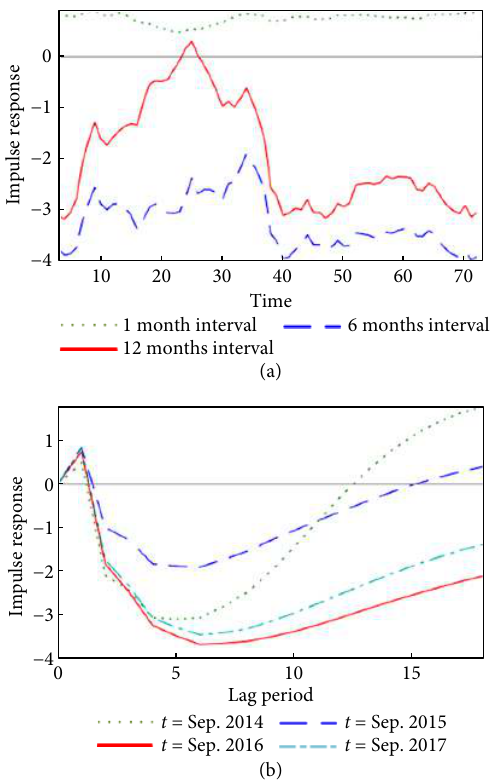
Fig. 4 Equidistant (a) and time-point (b) impulse responses of DTOM to